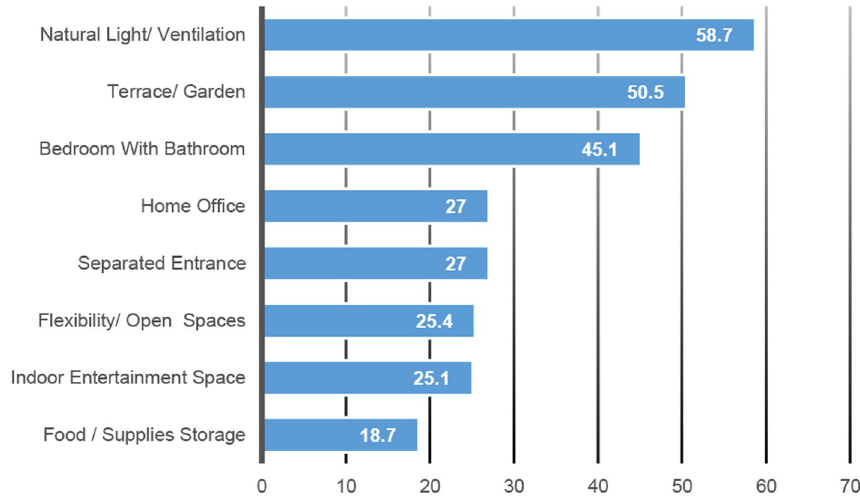
Fig. 4 Percentage of participants’ ratings of indicators being of “Extreme Importance” ranked by means. Ref: researchers